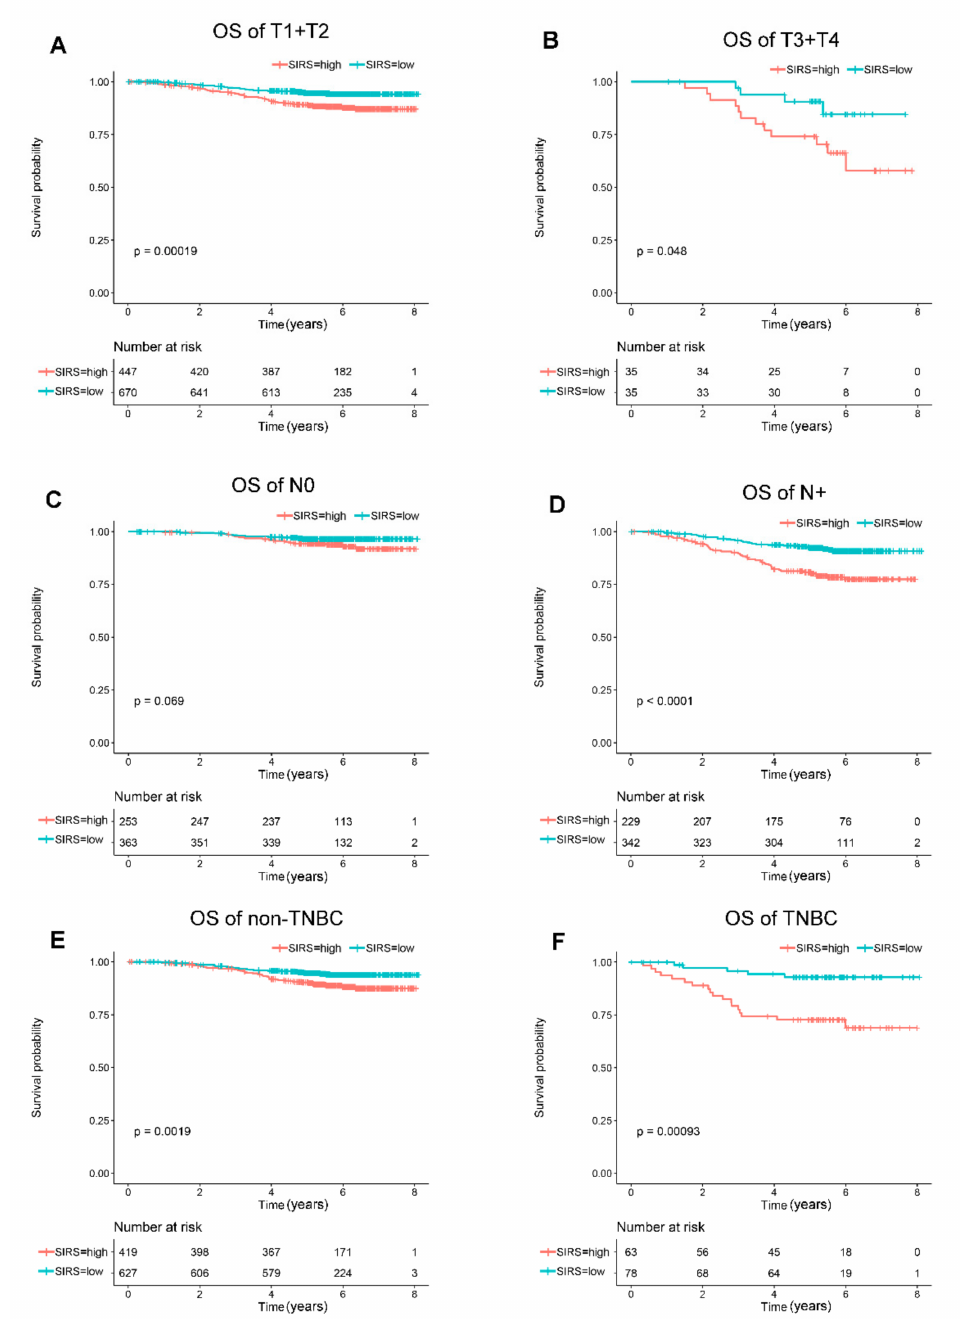
Figure 2. Subgroup-based Kaplan–Meier analysis for breast cancer patients between SIRS and OS. ( A ). Kaplan–Meier curves for the overall survival of patients with T1/T2 tumor. ( B ). Kaplan– Meier curves for the overall survival of patients with T3/T4 tumor. ( C ). Kaplan–Meier curves for the overall survival of patients with no lymph node metastasis. ( D ). Kaplan–Meier curves for the overall survival of patients with positive lymph node metastasis. ( E ). Kaplan–Meier curves for the overall survival of non-triple negative breast cancer patients. ( F ). Kaplan–Meier curves for the overall survival of triple negative breast cancer